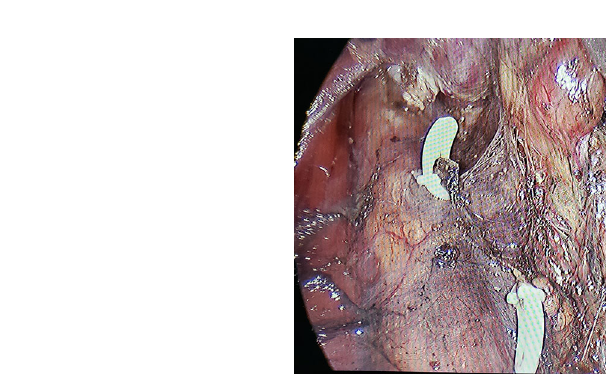
FIGURE 2 Trachea, nerve, blood vessel, parathyroid, imaging.